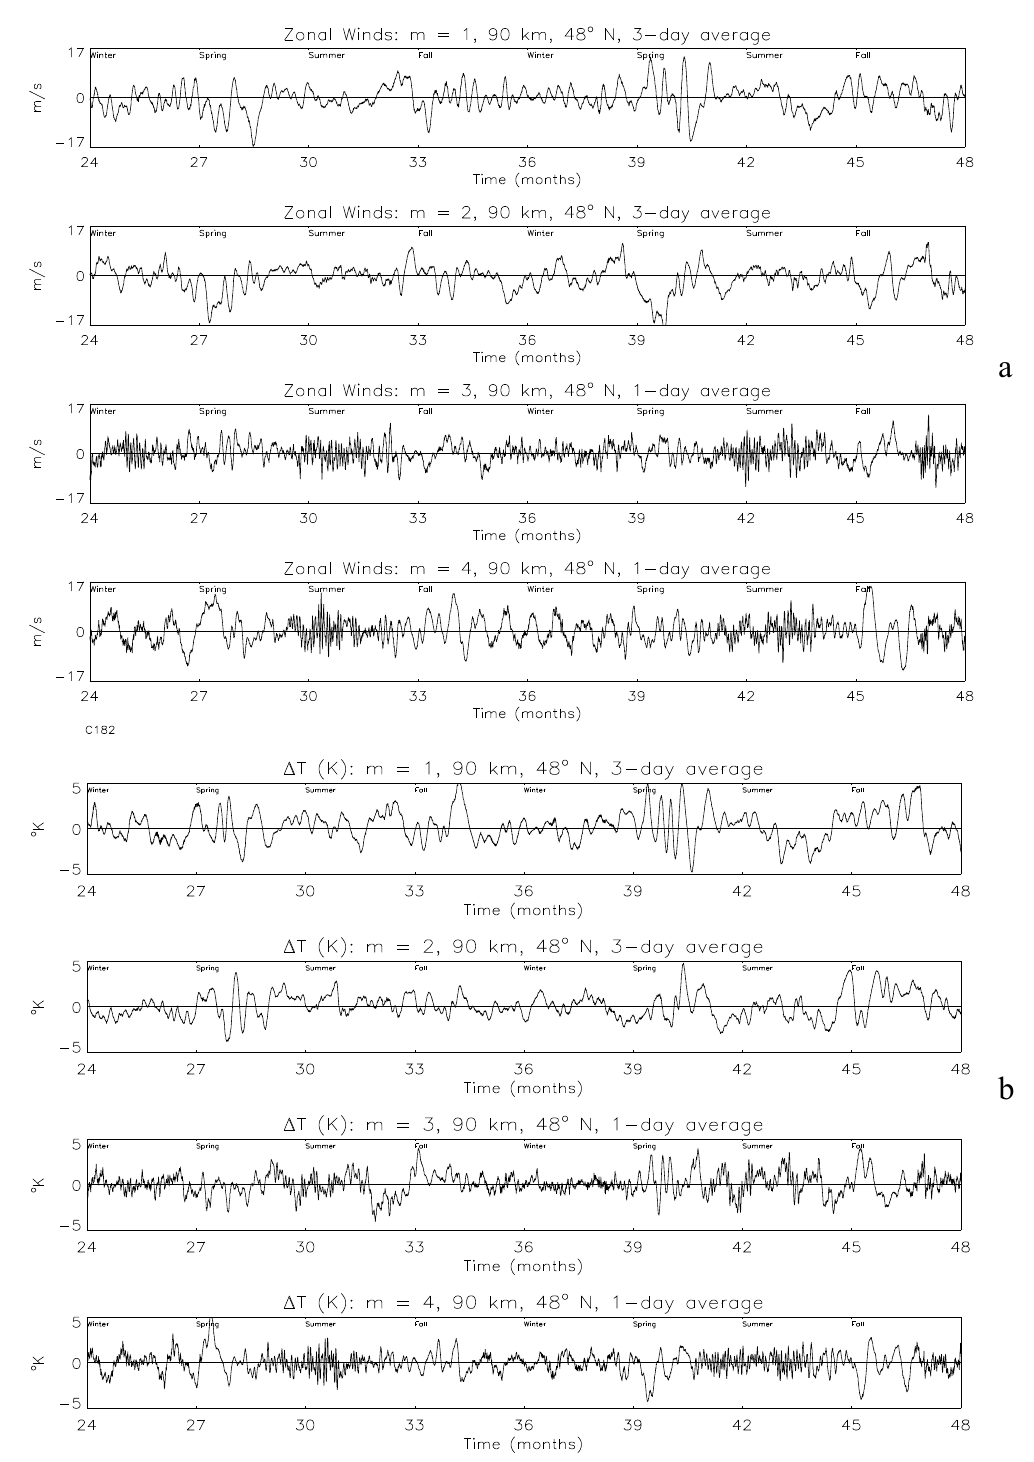
Fig. 4. Zonal wind ( a ) and temperature perturbations ( b ) of PWs for m=1 to 4 at 90km altitude and 48 ◦ latitude, computed at 0 ◦ longitude over a time span of 2 years with the standard model that includes the tropospheric heat source. Note the persistent seasonal variations, e.g. the short period (2- to 3-day) waves during summer months for m=3 and 4, and the long period waves during spring and fall in particular for m=1 and